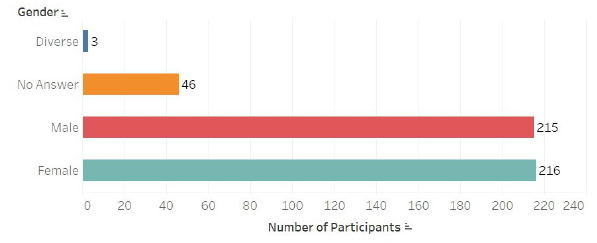
Figure 4. Gender distribution